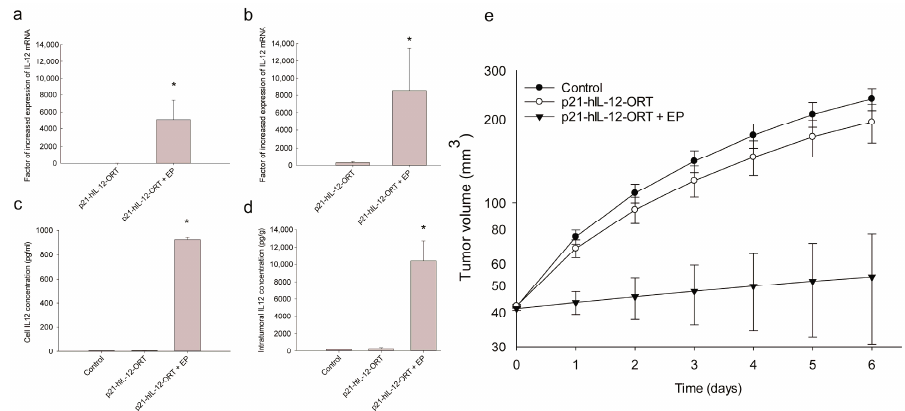
Figure 2. Expression of human interleukin 12 (hIL-12) and tumor growth after p21-hIL-12-ORT GET: Levels of hIL-12 mRNA 1 day after GET of p21-hIL-12-ORT in B16F10 cells ( a ) and in tumors ( b ) normalized to the mRNA levels in the control group; Concentration of hIL-12 protein 3 days after p21-hIL-12-ORT GET in cell media ( c ) and intratumorally ( d ); ( e ) Growth of B16F10 tumors after p21-hIL-12-ORT GET: intratumoral injection of H 2 O alone (Control), plasmid alone (p21-hIL-12-ORT), or in combination with application of EP (p21-hIL-12-ORT + EP). Data are presented as the mean with the standard error of the mean. In vitro experiments were repeated 3 times independently, and 6 animals per experimental group were included in the in vivo experiments. * p < 0.05 vs. Control and p21-hIL-12-ORT.